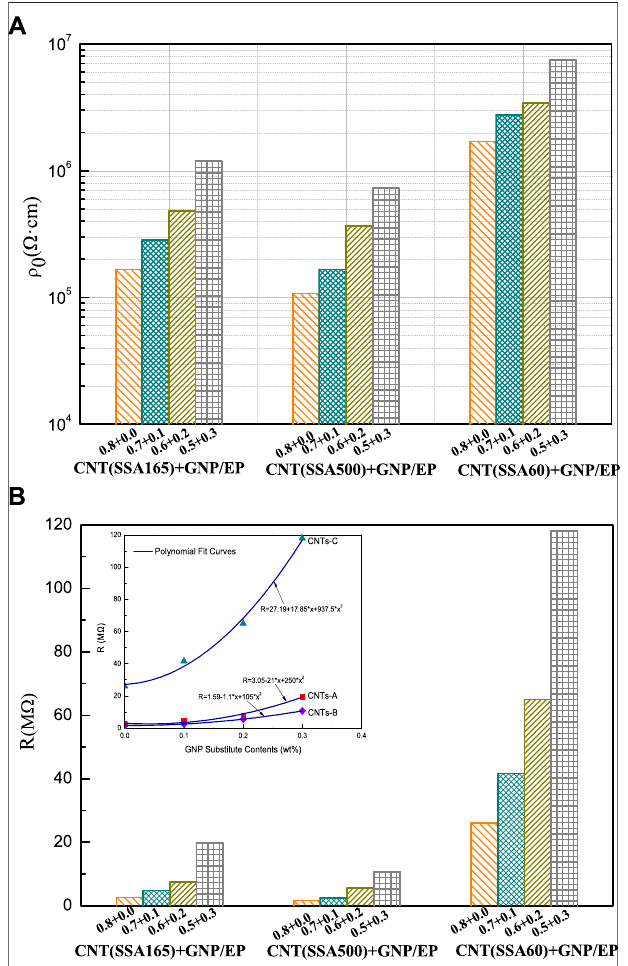
FIGURE 5 | Electrical resistivity (A) and resistance (B) variation of composites with different fi llers.